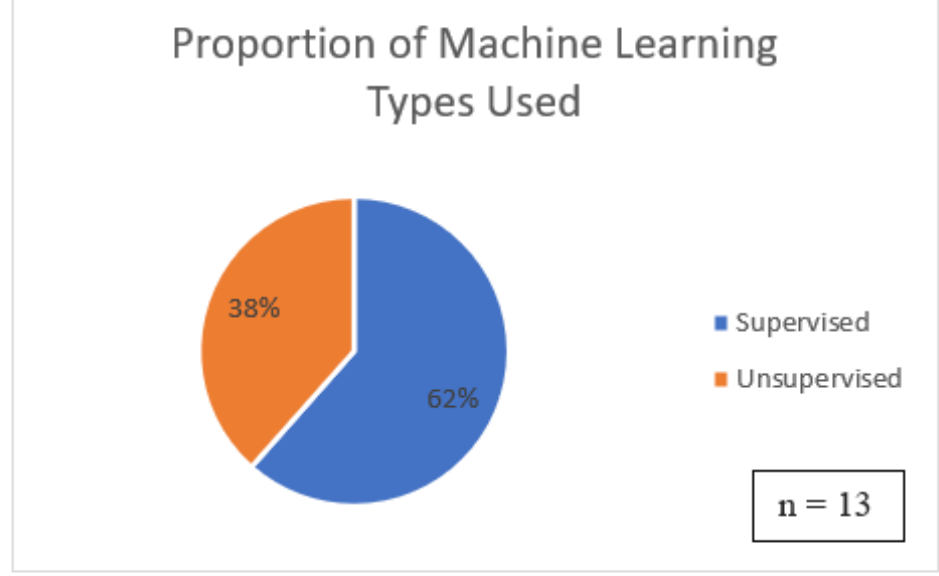
Figure 5. The proportion of ML types in the